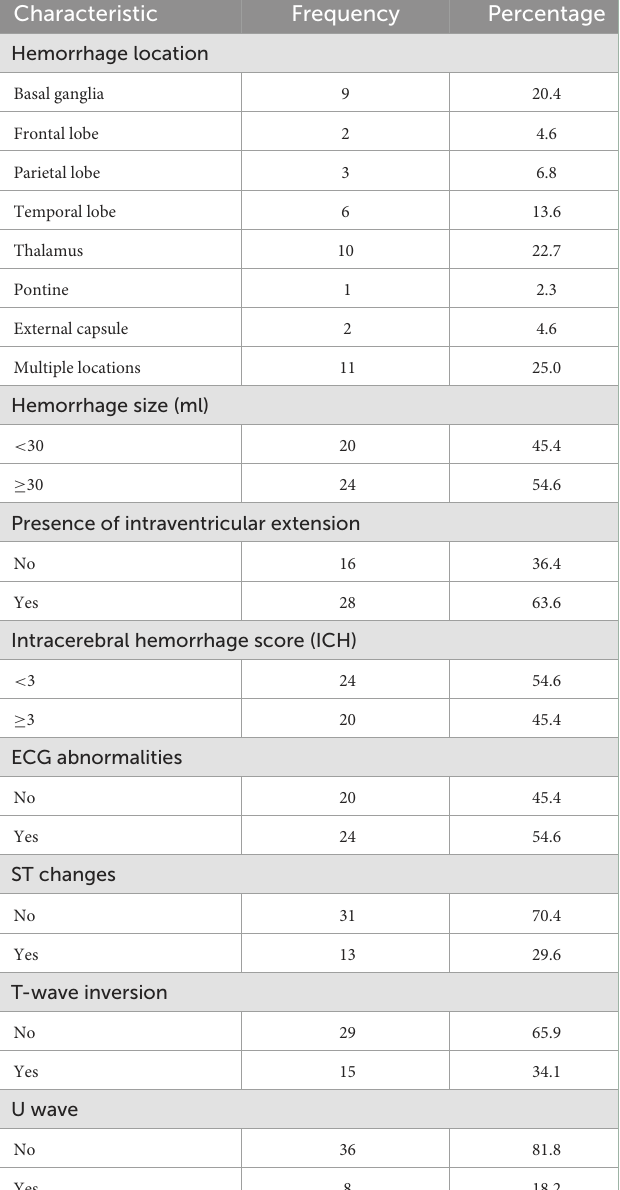
TABLE 3 Neuroimaging and ECG abnormalities among patients with hemorrhagic stroke ( N = 44). Characteristic Frequency Percentage Hemorrhage location Basal ganglia Frontal lobe Parietal lobe